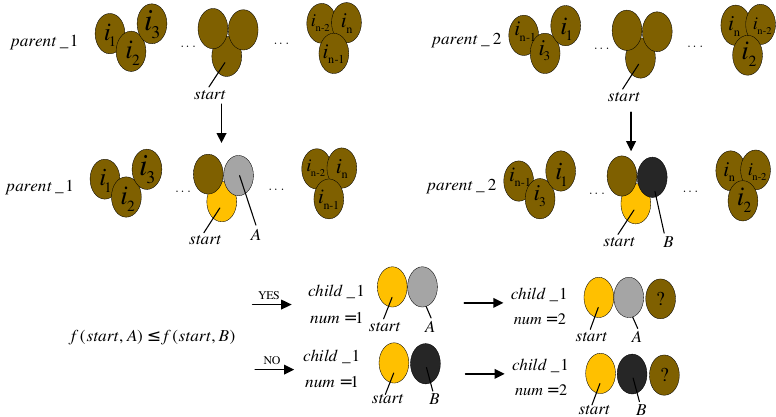
Figure 6. Schematic diagram of brainstorming crossover